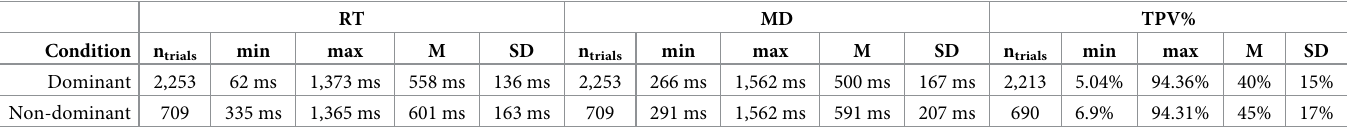
Table 2. Descriptive statistics ( n participants = 19).